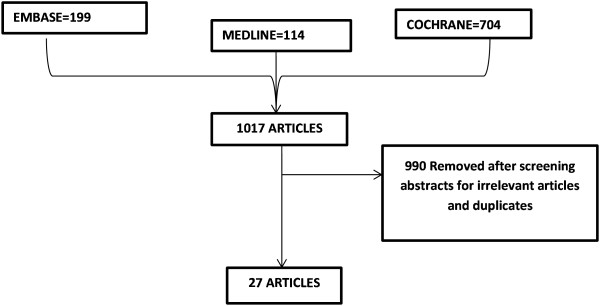
Flow chart for studies included in the systematic review.